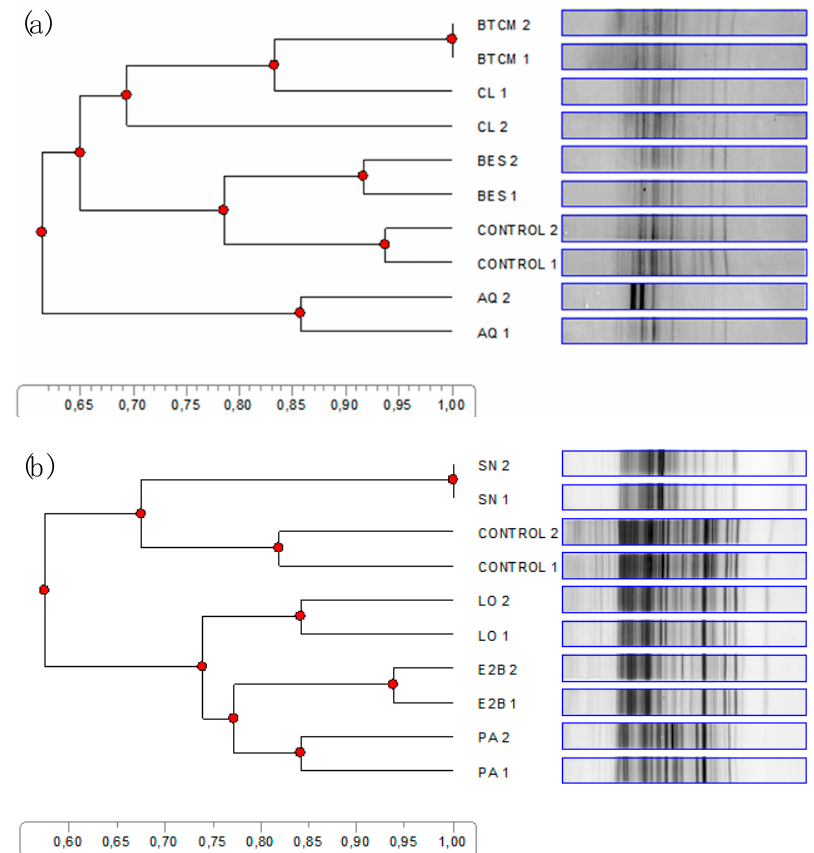
Figure 3. Dendrogram of bacterial denaturing gradient gel electrophoresis (DGGE) profile of the rumen in vitro batch cultures. ( a ) DGGE bacterial profiles of: BTCM, bromotrichlorometane; CL, chloroform; BES, 2-bromoethanesulfonate; Control, control treatment containing no inhibitor; AQ, 9,10-anthraquinone; ( b ) DGGE bacterial profiles of: SN, sodium nitrate; Control, control treatment containing no inhibitor; LO, linseed oil; E2B, ethyl-2-butynoate; PA, propynoic acid. Samples of two replicates per treatment of incubation run three were run on two DGGE gels.